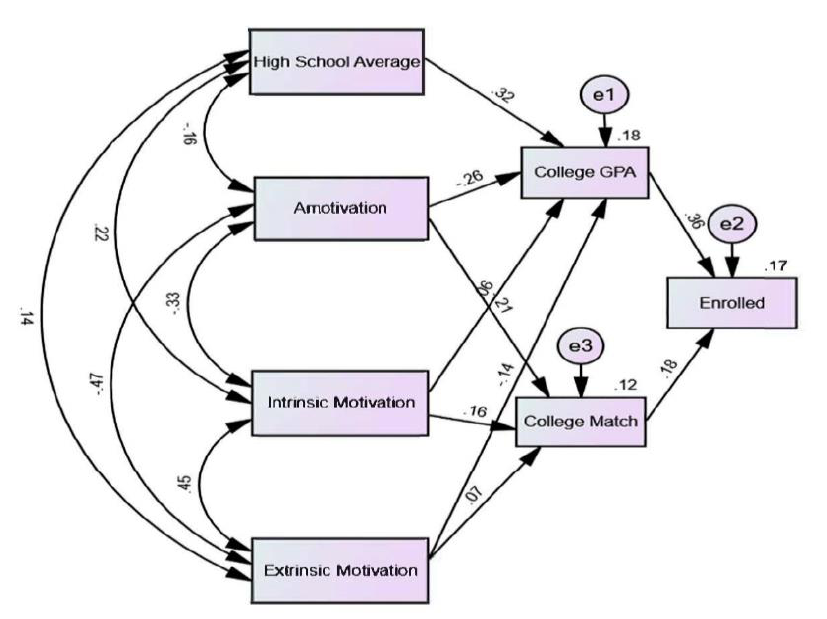
Study 2: Path analysis model of associations between motivational orientation and enrollment